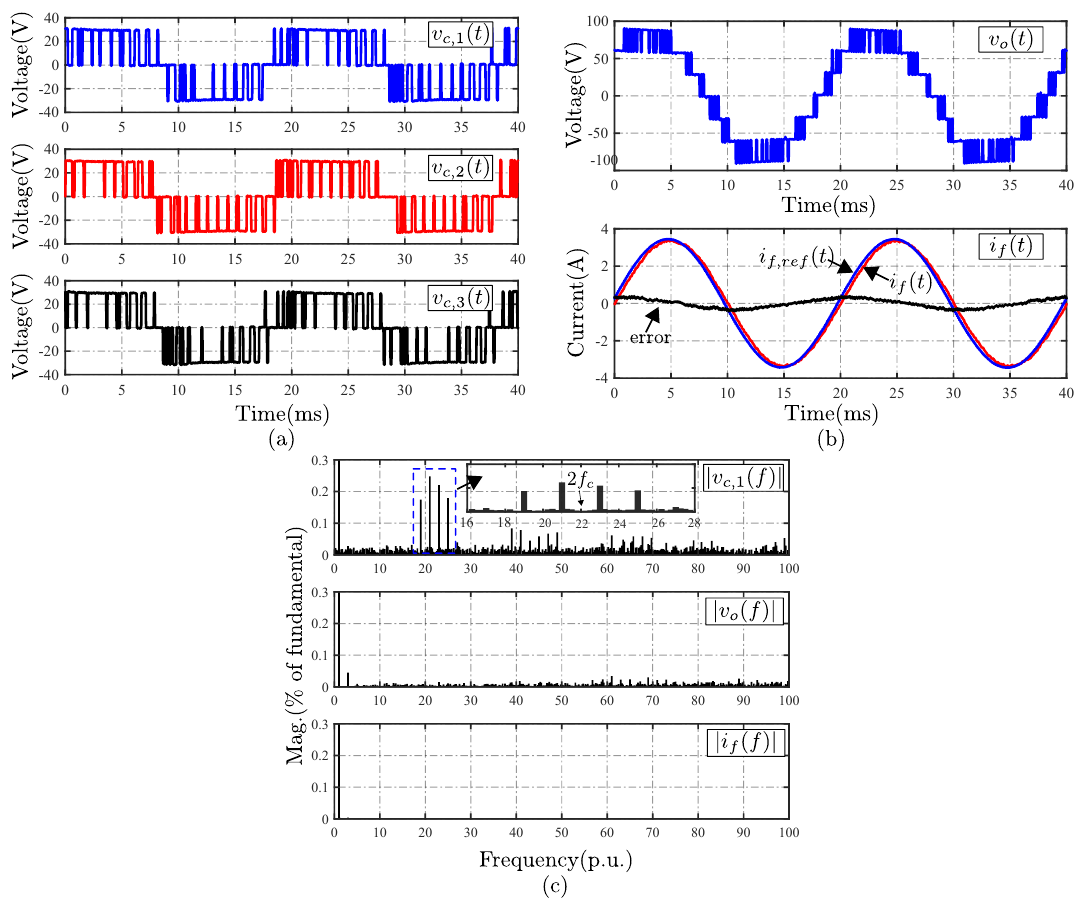
Figure 8. Experimental results for proposed FCS-MPC. ( a ) cells voltage; ( b ) output voltage and current; ( c ) key-waveforms harmonic